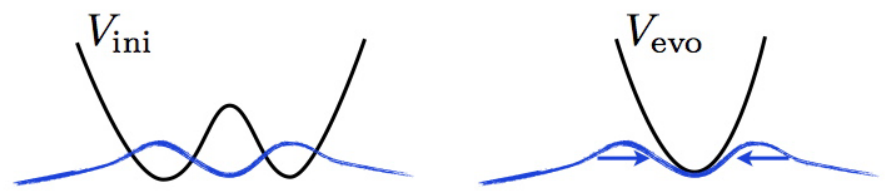
Figure 1: A sudden change of the shape of the longitudinal potential induces a large- scale motion in the gas.